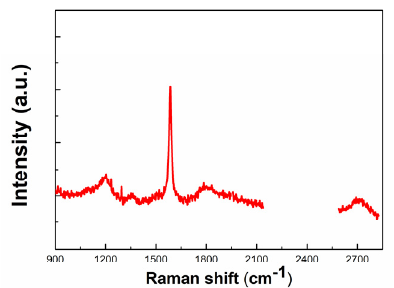
Figure 3. Raman spectrum of the graphene / TPU strain sensor.